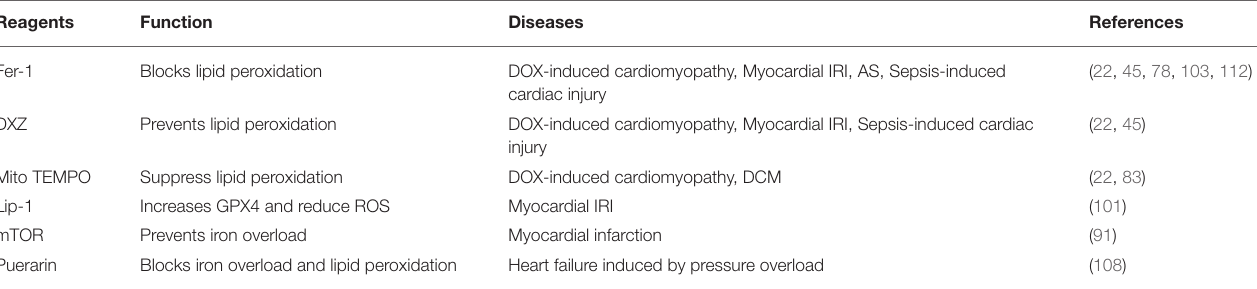
TABLE 3 | Potential therapeutic strategy for